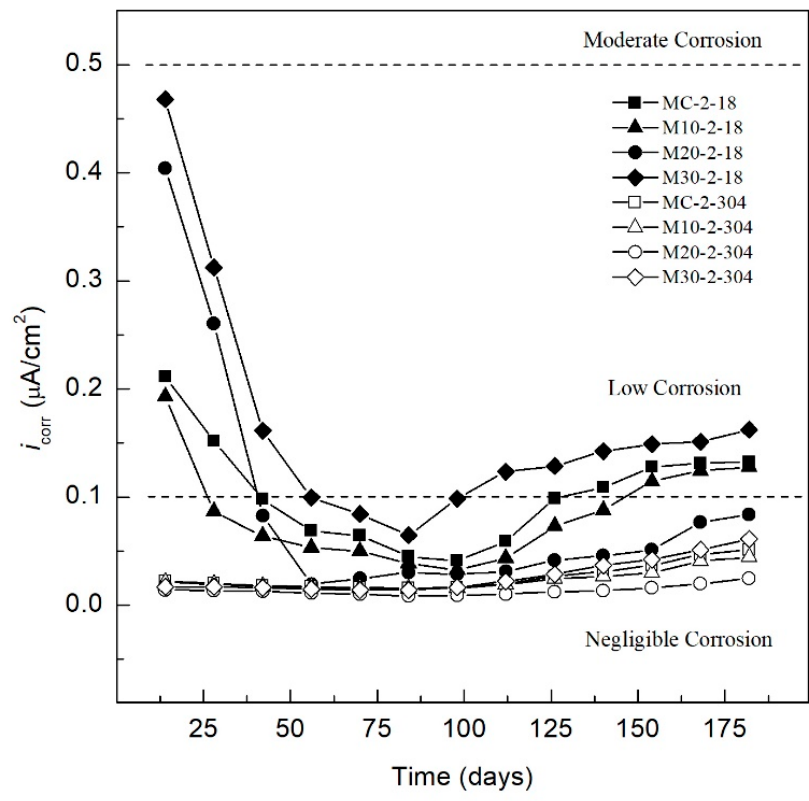
Figure 5. i corr specimens exposed to 3.5 wt.% MgSO 4 solution.